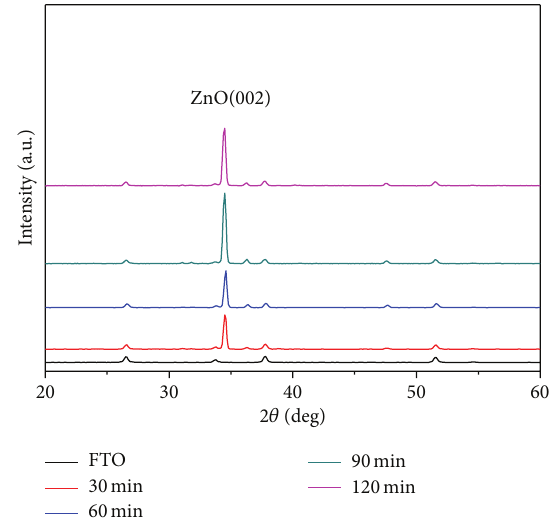
Figure1:XRDspectraofZnOnanowiresgrownonFTOconducting glass.